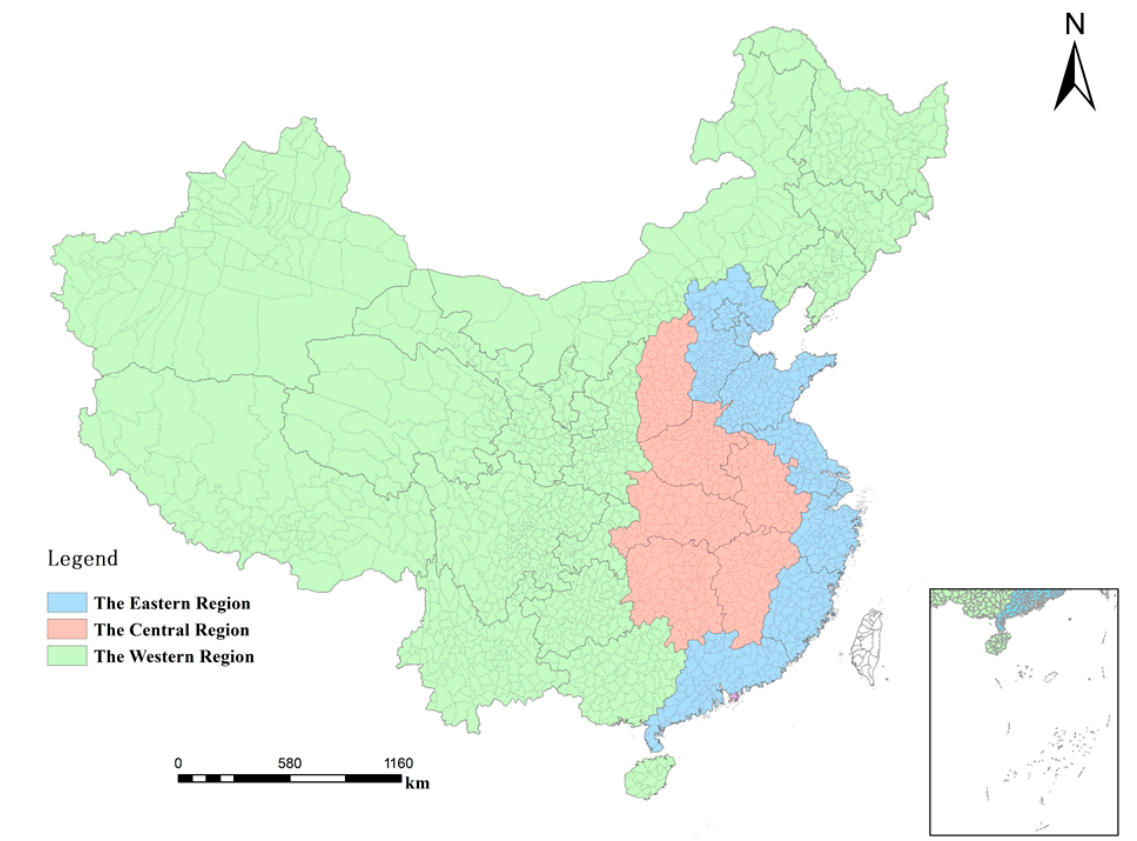
Figure 5. The eastern, central, and western regions of China.